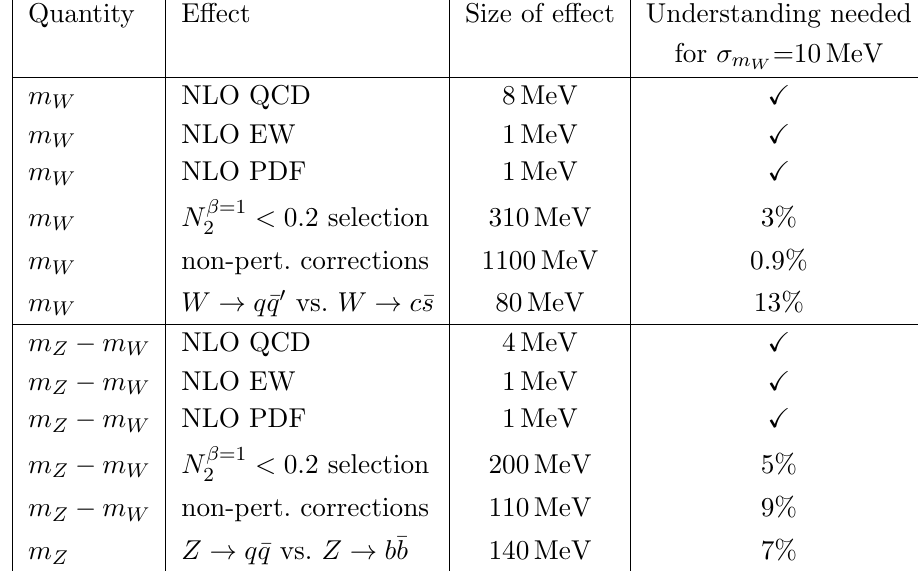
Table 5 . List of systematic e(cid:11)ects. The understanding needed for (cid:27) m = 10 MeV is the fraction of W 10 MeV and the quoted size of e(cid:11)ect. It should be noted that yet better precision is needed to achieve a sum in quadrature of all systematic uncertainties of (cid:27) m = 10 MeV. Unless stated otherwise a W selection of p T > 300 GeV and N (cid:12) =1 2